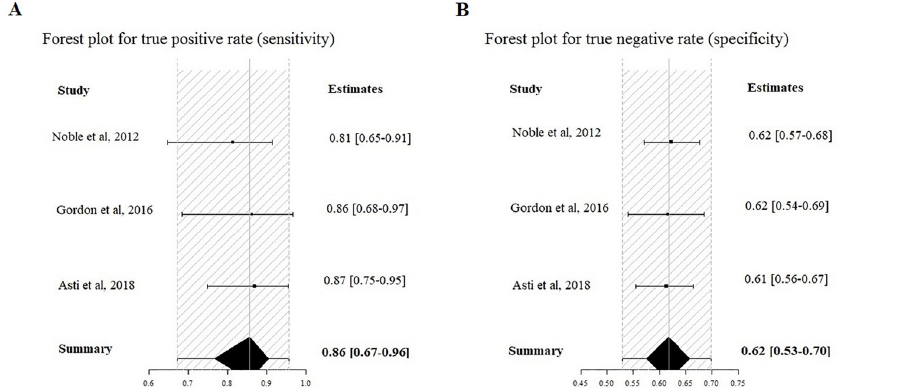
Fig 8. Forrest Plot for POD5: Estimated pooled sensibility (A) and specificity (B).